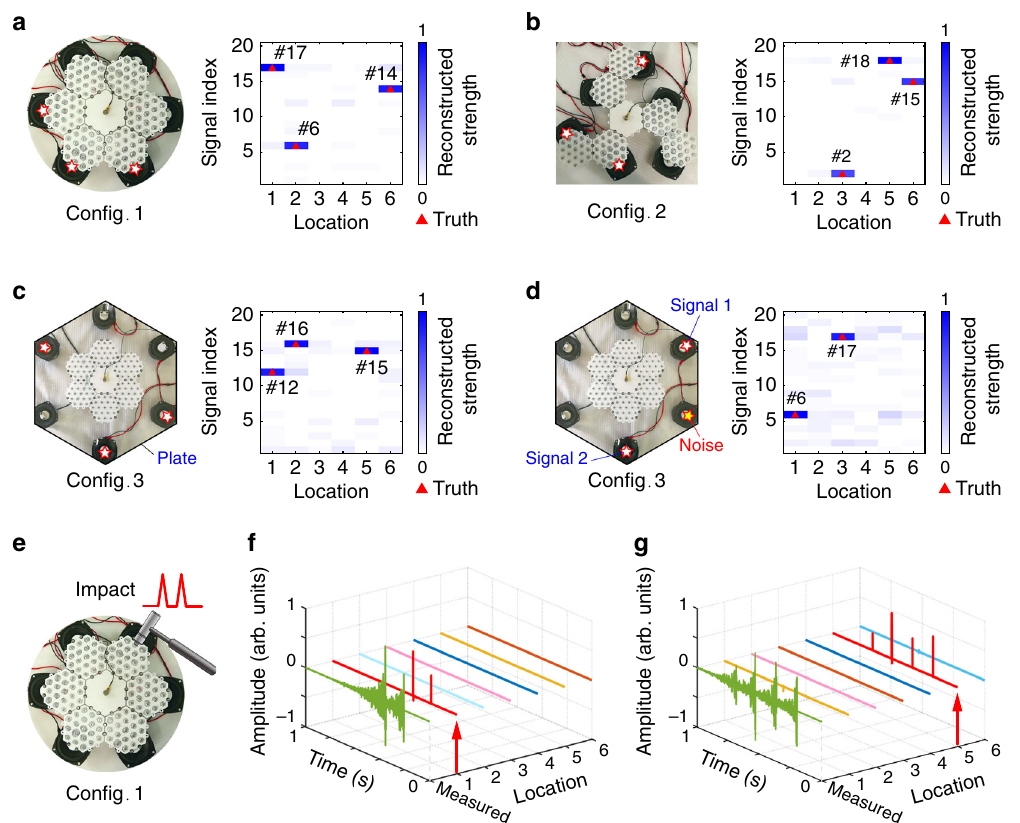
Fig. 4 Vibration identi fi cation of the metamaterial system. a Experimental setup of Con fi g. 1 and a reconstruction result with three activated vibration sources. b Experimental setup and reconstruction results of Con fi g. 2. c Experimental setup and reconstruction results of Con fi g. 3. d Vibration identi fi cation of Con fi g. 3 under noise interferences. e Experimental setup for impact identi fi cation. f Reconstruction result with two consecutive impulses applied to Location 1. g Reconstruction result with four consecutive impulses applied to Location